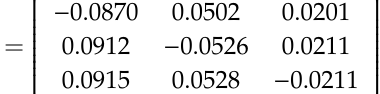
Figure 3. Typical structure diagram of PV and wind power-based microgrid.